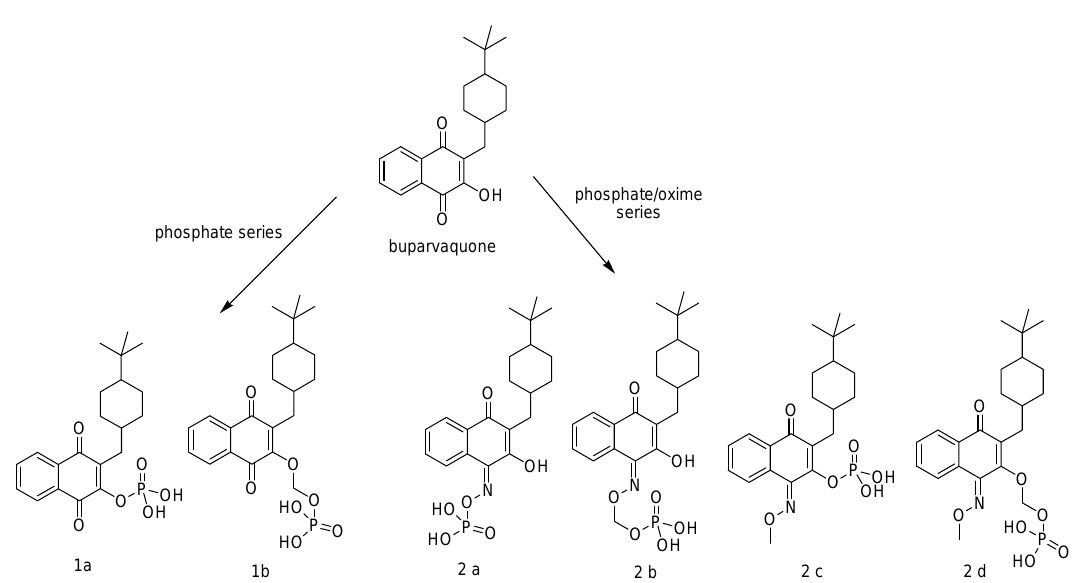
Figure 11. Chemical structures of buparvaquone and its